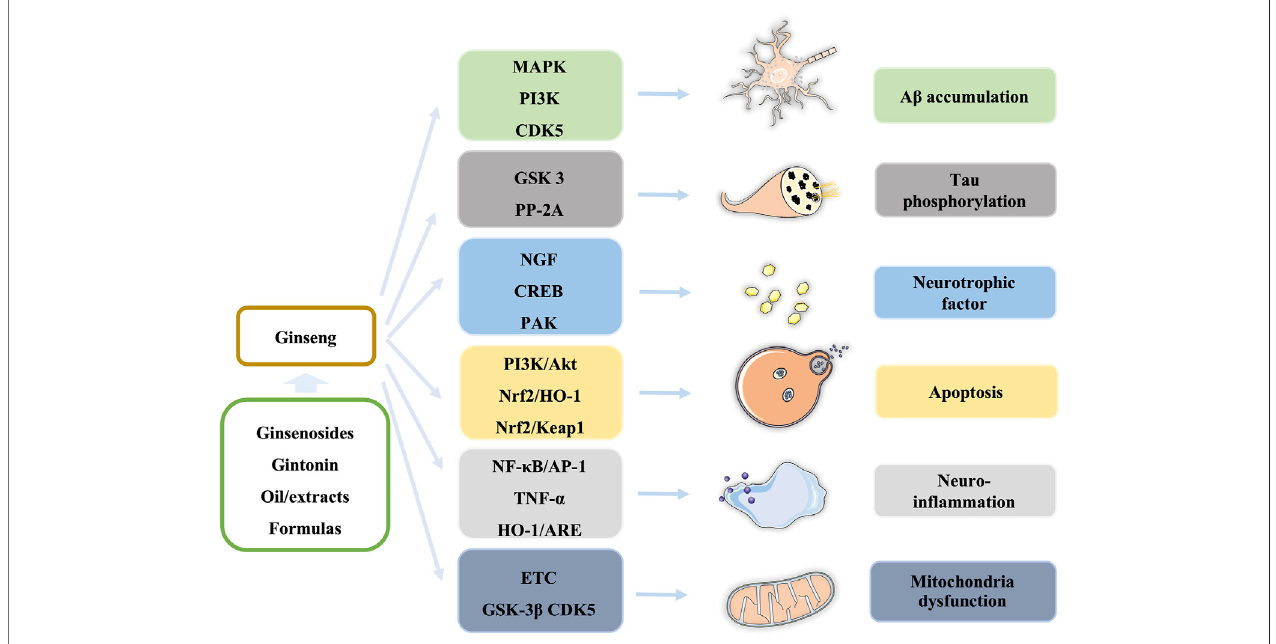
FIGURE 3 | Summary of ginseng components and the affected pathways in the pathological process of